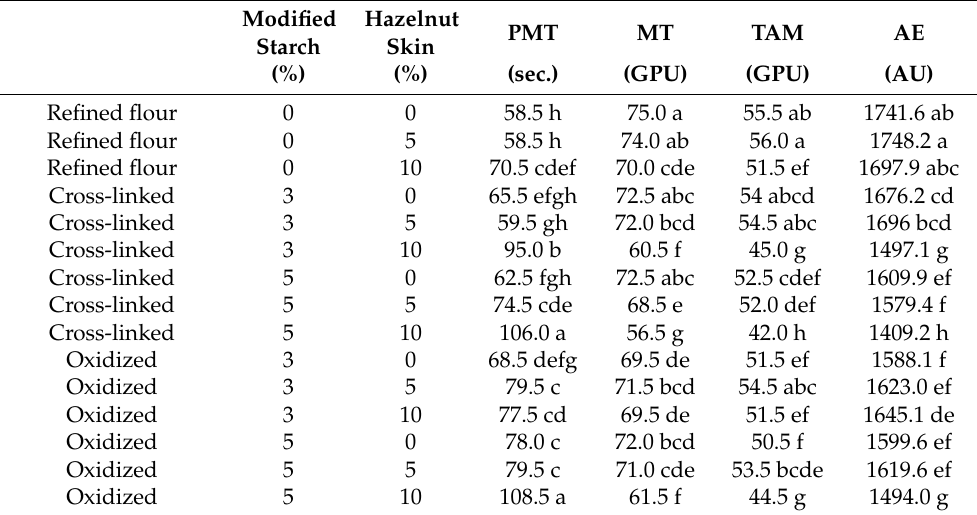
Table 1. Glutopeak test results of dough prepared with hazelnut skin and modified